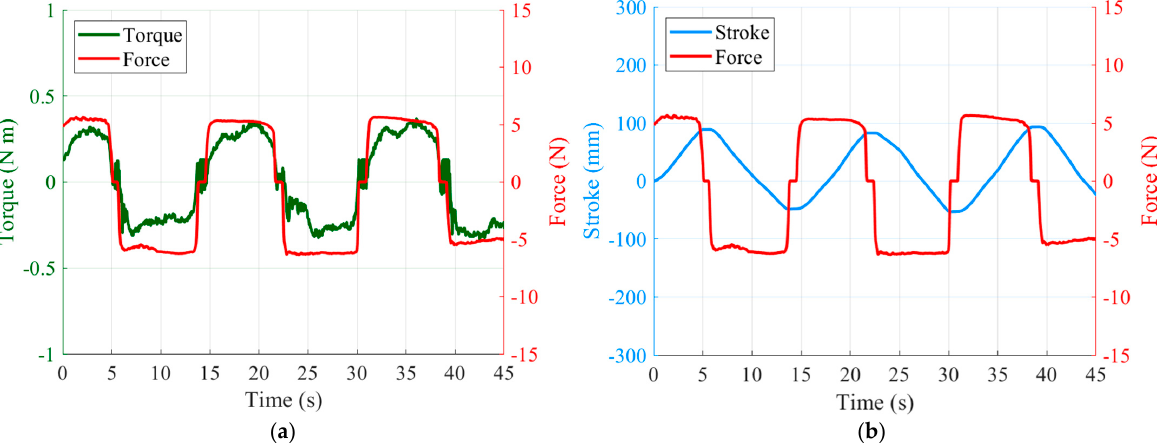
Figure 10. Experimental results of hand guiding: ( a ) estimated torque and force plot; ( b ) stroke and force plot. Sensors 2021 , 21 , 3498